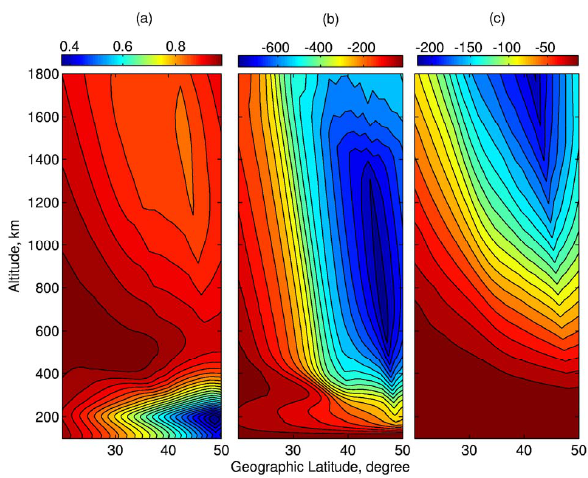
575 Figure 4. Contours of the relative change in electron density (a), Ne E /Ne C , electron temperature 576 Fig. 4. Contours of the relative change in electron density (a) , (b), Te E – Te C , and ion O + drift velocity along field line (positive upward) (c), ViO E – ViO C , as a 577 Ne E /Ne C , electron temperature (b) , Te E – Te C , and ion O + drift function of geographic latitude and altitude at 1021 UT. The longitude is about 1.67° E. These 578 velocity along field line (positive upward) (c) , ViO E –ViO C , as a results are calculated by the ionospheric model. 579 function of geographic latitude and altitude at 10:21 UT. The lon- 580 gitude is about 1.67 ◦ E. These results are calculated by the iono- spheric